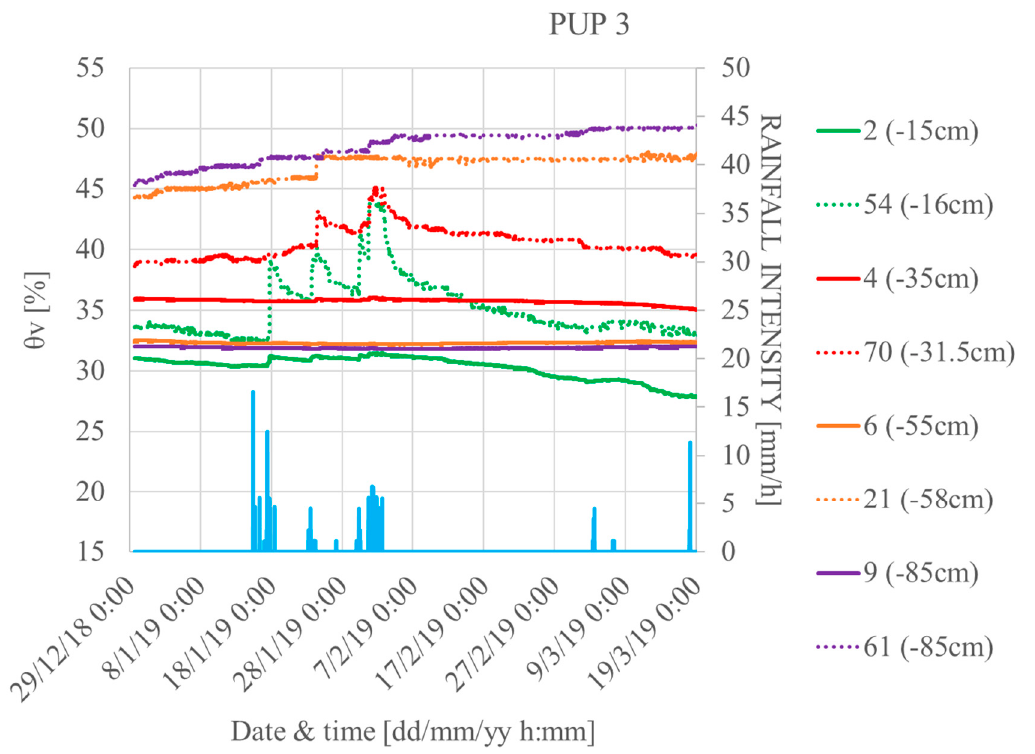
Figure 12. Measurements by WaterScout n.54, n.70, n.21 and n.61 and by the pertinent reference sensors n.2, n.4, n.6 and n.9 of Drill&Drop for 29 December 2018 to 19 March 2019.